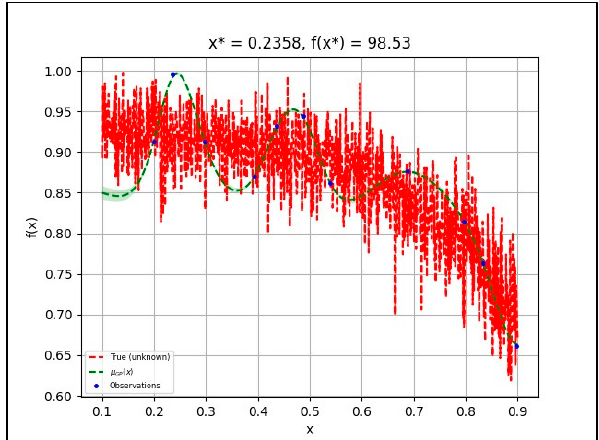
Figure 9. Bayesian optimization tuning dropout rate for VGG-Net.